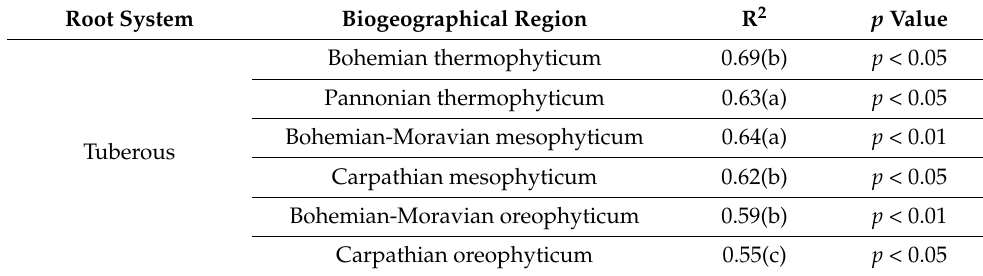
Figure 4. Density of tuberous, intermediate and rhizomatous orchid taxa recorded at different altitudes in the phytogeographical region of: ( a ) Bohemian thermophyticum, ( b ) Bohemian-Moravian mesophyticum, ( c ) Bohemian-Moravian oreophyticum, ( d ) Pannonian thermophyticum, ( e ) Carpathian mesophyticum and ( f ) Carpathian oreophyticum. Table 2. Summary statistics of the polynomial regressions used for determining the relationship between orchid diversity and altitude.